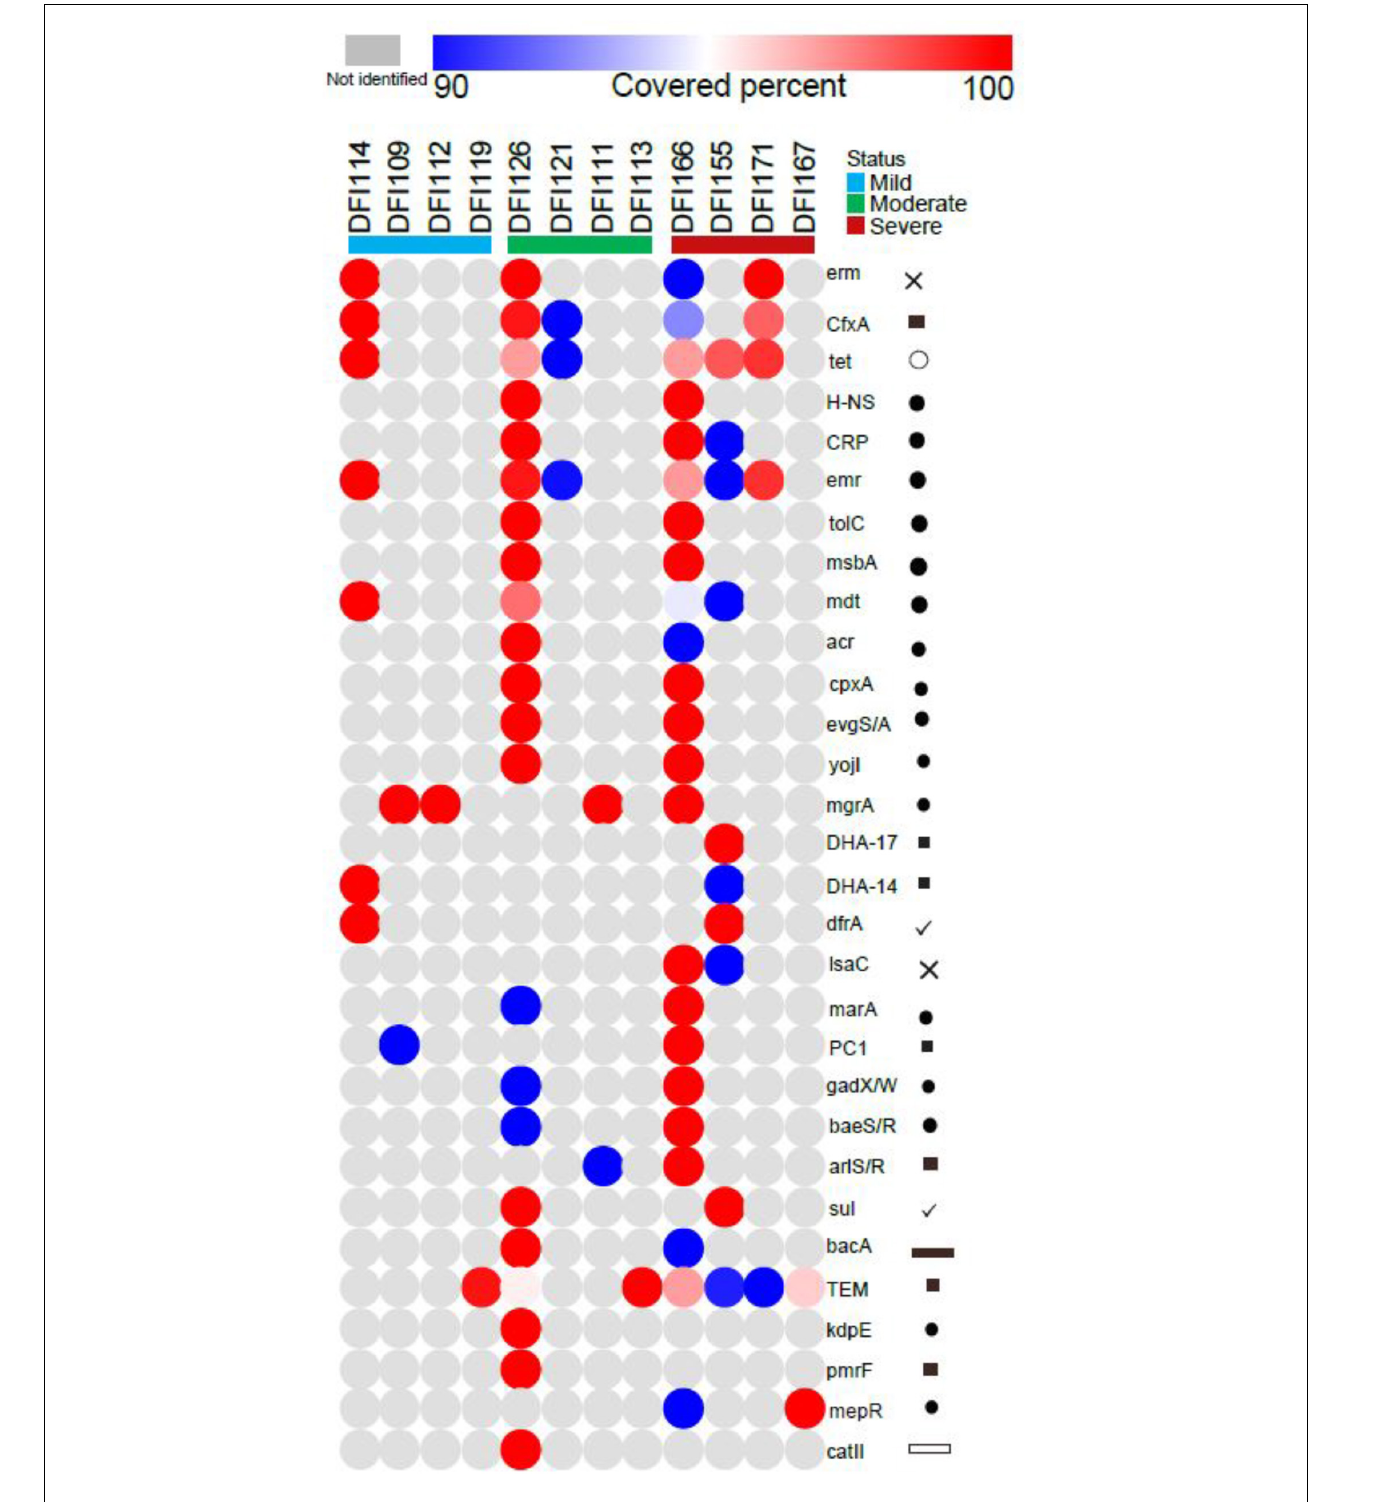
FIGURE 6 | Detected antibiotic resistome in 12 DFI samples using the CARD. Antibiotic resistance genes encoding beta-lactam, macrolide, and tetracycline antibiotics were annotated mostly in moderate and severe infection. Genes related to multidrug efflux pumps/exporters and beta-lactam antibiotics were detected in 11 samples ( × : macrolides, (cid:4) : β -lactam, ◦ : polyketides, • : multidrug efflux pumps/exporters, : sulfonamide, trimethoprim, : bacitracin, : chloramphenicol). Circle color indicates the percentage coverage of the reference CARD sequence by the RNA-seq data (red/blue) or the absence in a sample (gray). (cid:8) Similar genes with similar functions were considered as one group. For instance, TEM-1, TEM-116, TEM-198, and TEM-157 were grouped as TEM.